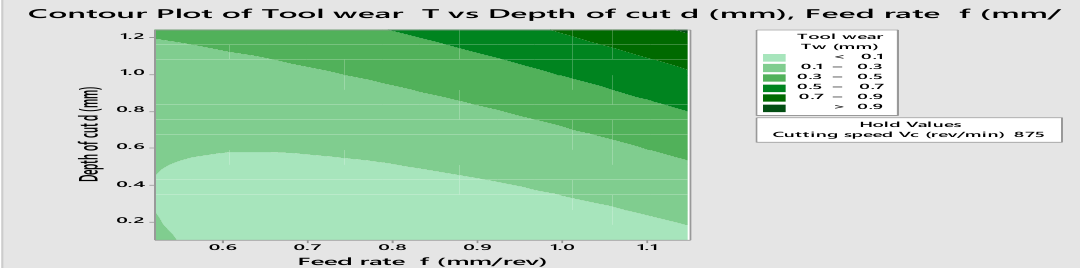
Figure 16: Contour plot for tool wear with MBCF